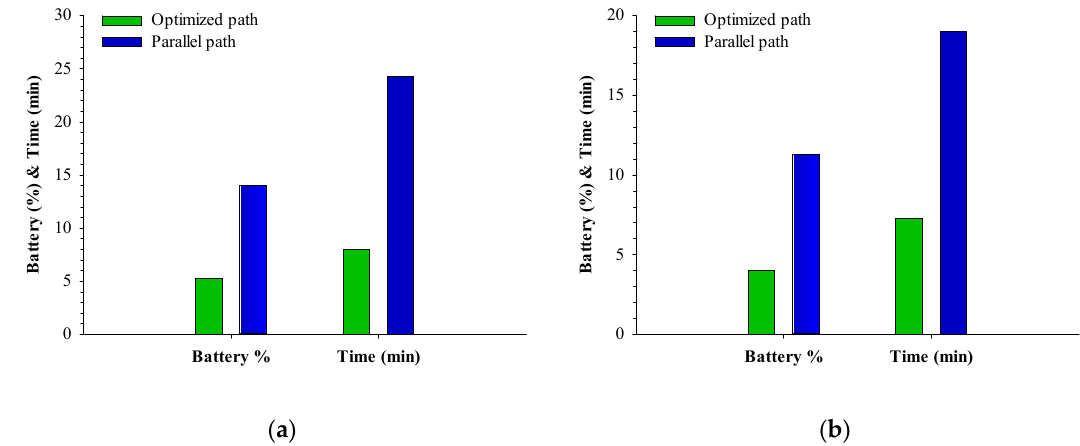
Figure 17. Battery power consumed and flight time comparison for ( a ) region R1 and ( b ) region R2.